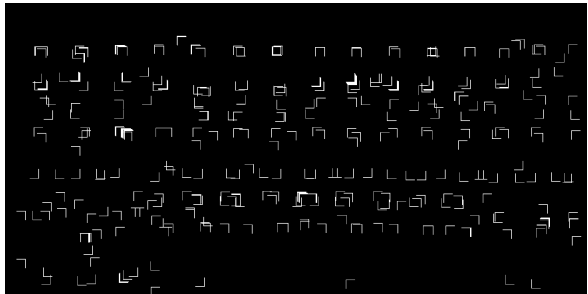
Figure 3. Primitives extracted after non-maximum suppression